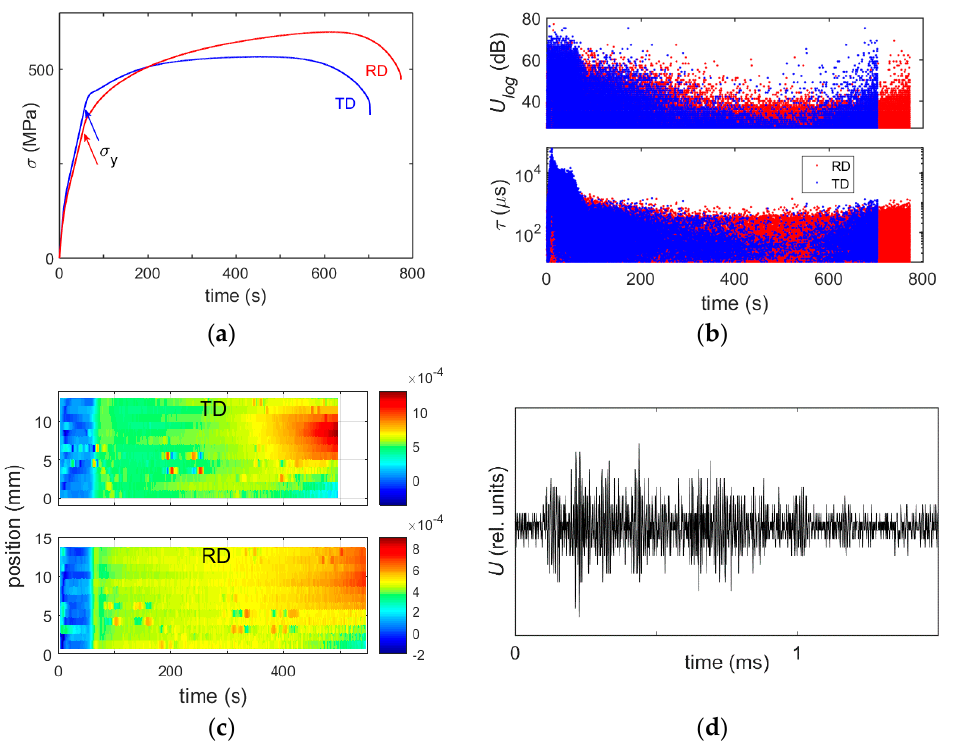
Figure 2. ( a ) Examples of stress-time curves for a transverse direction (TD) and rolling direction (RD) samples deformed at 5 × 10 − 4 s − 1 . The offset yield point σ y corresponds to 0.2% of plastic strain; ( b ) logarithmic amplitude U log and duration τ for the series of AE events detected during the test; ( c ) spatiotemporal pattern displaying the evolution of the local strain rate loc the specimen. Color bar is scaled in s − 1 ; and ( d ) example of waveform for an AE event.